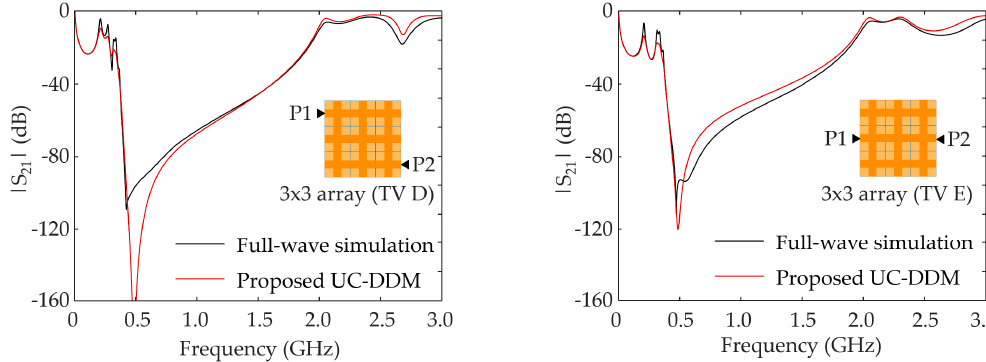
Figure 11. Comparison of PPN suppressions for 3 × 3 arrays (TV D and TV E) of different port configurations. Table 2. PPN suppressions and computation time of the UC-DDM and the full-wave simulation.